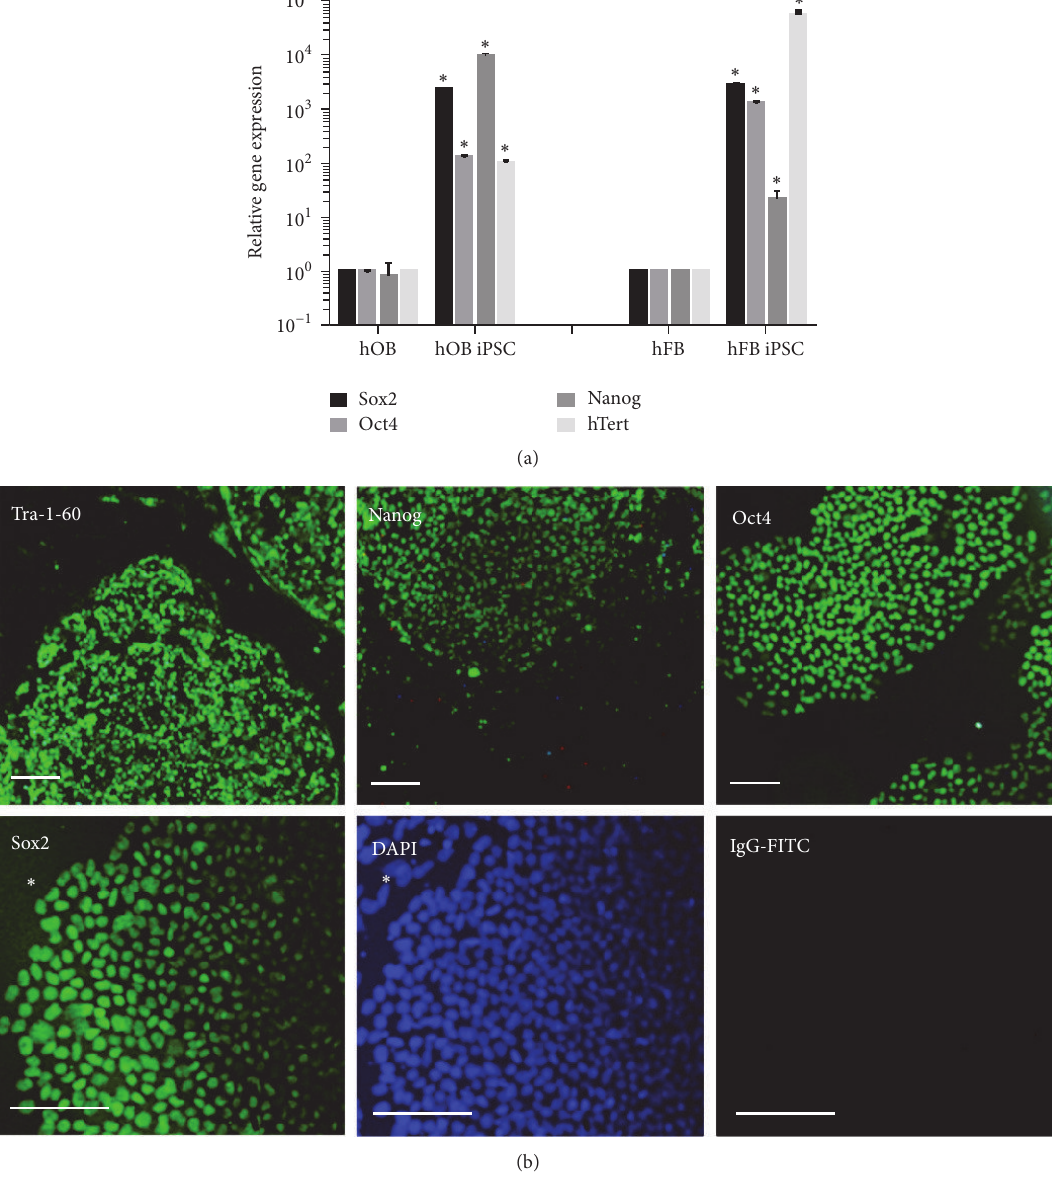
Figure 2: Pluripotent marker expression analysis of hOB-iPSCs and hFB-iPSCs. (a) hOB-iPSC and hFB-iPSC qRT-PCR expression of endogenous pluripotent genes, Sox2, Oct4, Nanog, and hTERT ( ∗ 𝑃 < 0.01 ). (b) Immunofluorescence of hOB-iPSC for pluripotency markers, TRA-1-60, Oct4, Nanog, Sox2, and IgG-FITC control (scale bars = 30 𝜇 m). ( ∗ indicates nonstaining MEF background.)